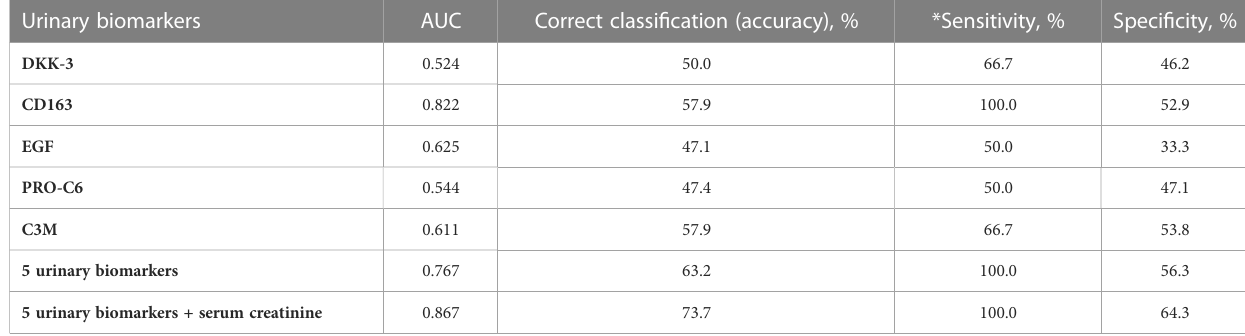
TABLE 5 AUC (from ROC), accuracy, sensitivity and speci fi city of the discrimination of Crescentic class from Sclerotic class with selected urinary biomarkers. Urinary biomarkers